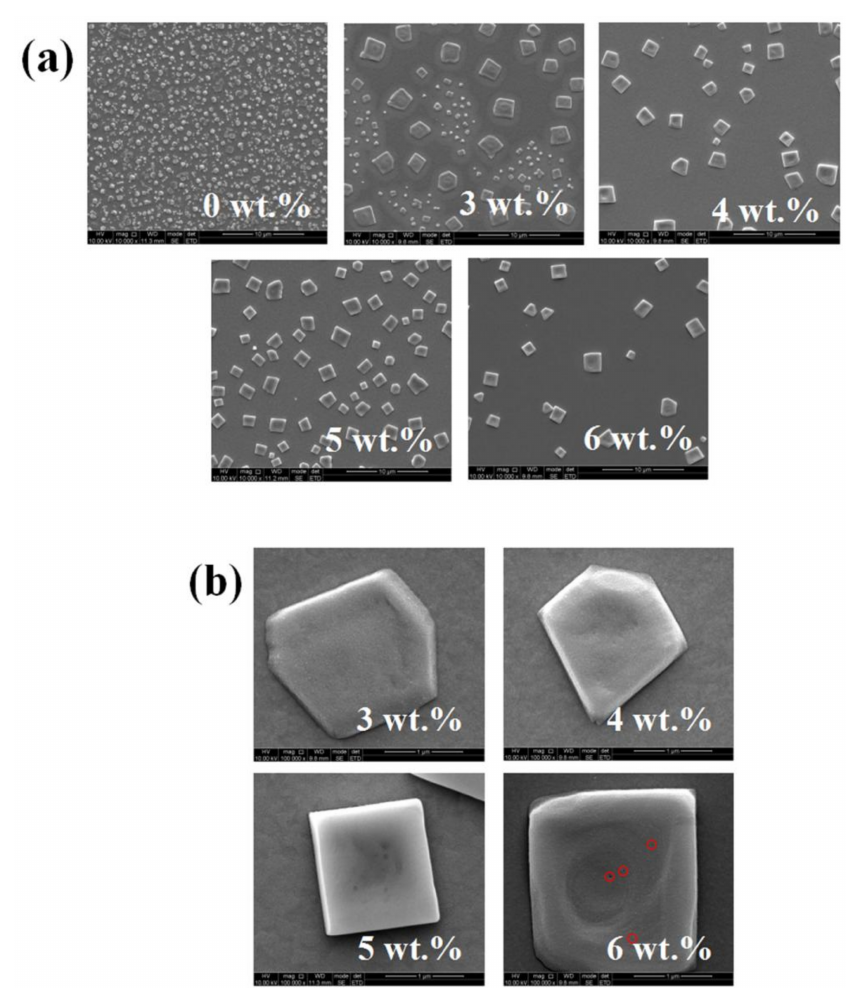
Figure 2. Top-view SEM images of MAPbBr 3 film. The scale bar is 10 µ m in ( a ) and 1 µ m in ( b